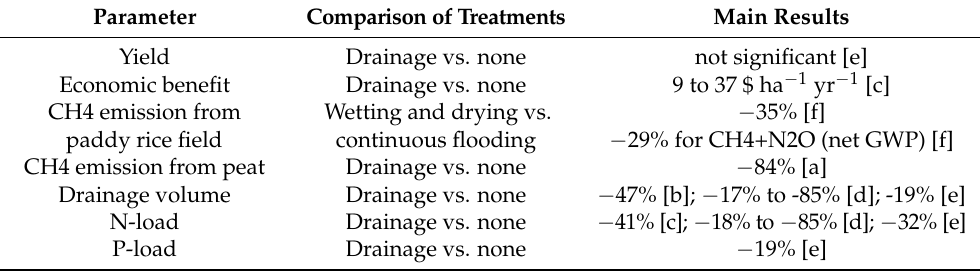
Table 2. Controlled drainage: effect sizes as reported in meta-analysis studies. See also Table S4. Parameter Comparison of Treatments Main